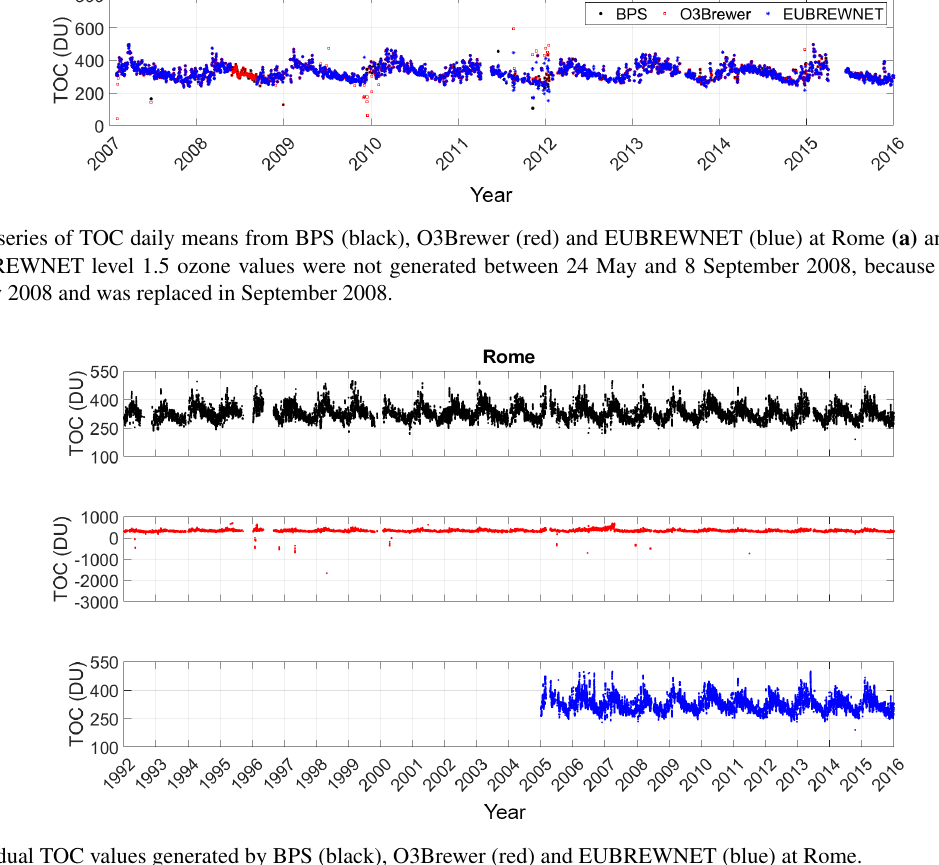
as the sum of BPS correction and R 6 ref . R 6 ref values